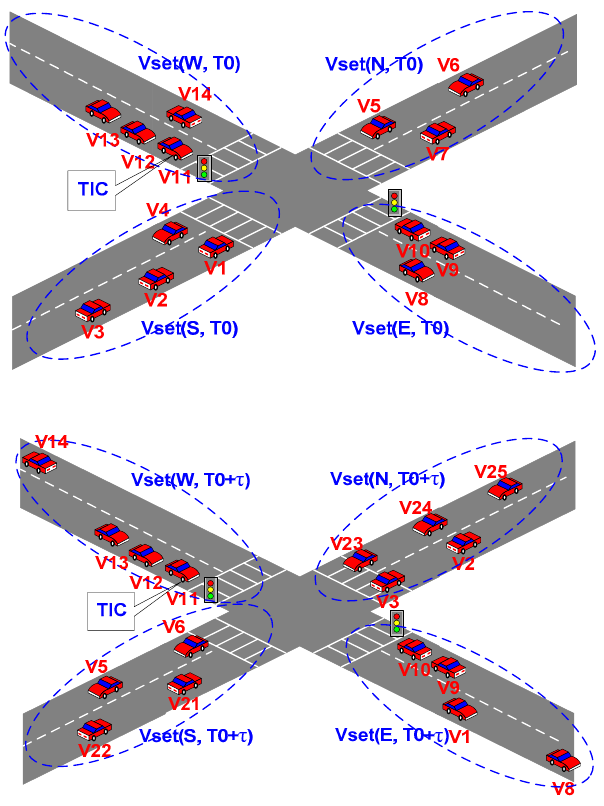
Figure 1. Traffic information collection.